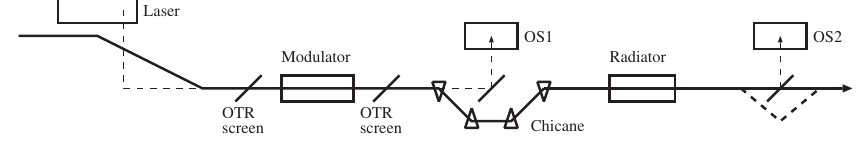
FIG. 1. The schematic setup of the experiment.